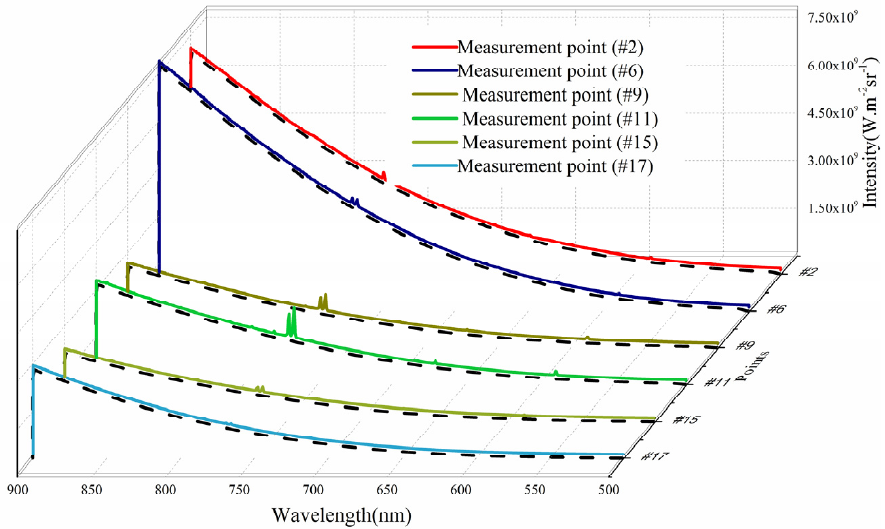
Figure 8. Calibrated intensity profiles of coal flames measured at eight of the eighteen measurement points. Table 2. The goodness-of-fit coefficient (GFC) values of selected profiles.